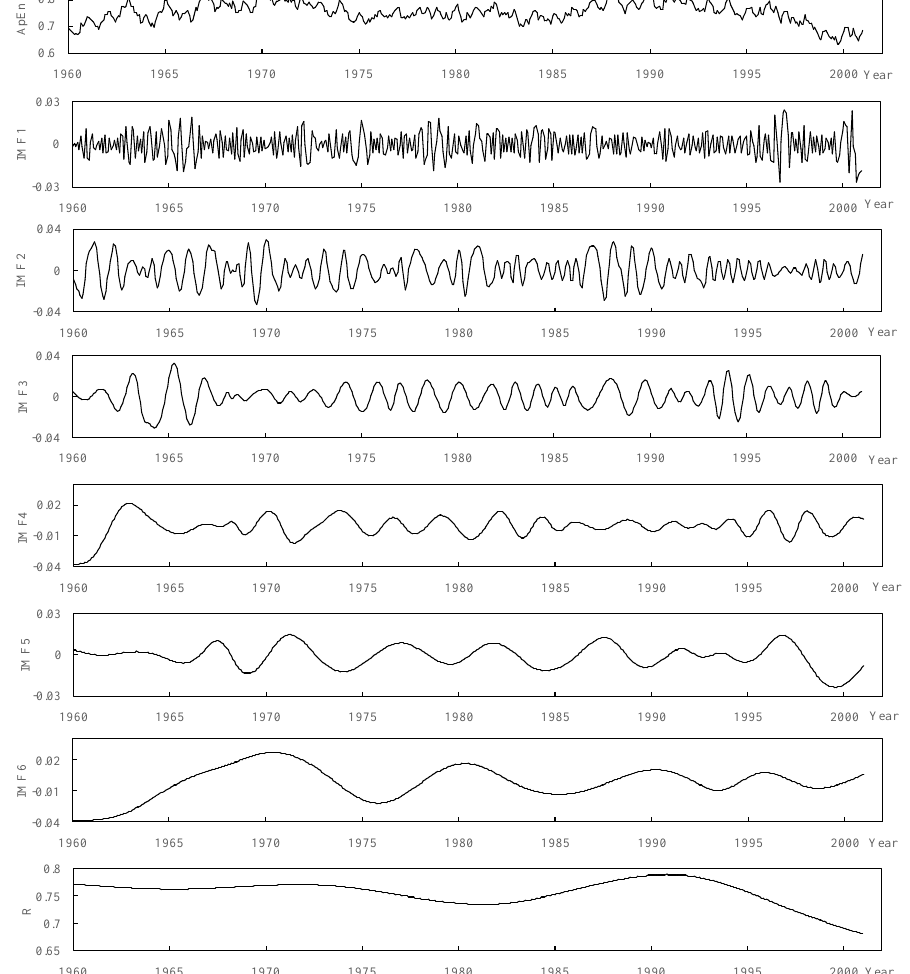
Figure 7. The Intrinsic Mode Function (IMF) components of precipitation ApEn by extreme-point Figure7. The Intrinsic Mode Function (IMF )components of precipitation ApEn by extreme-point symmetric mode decomposition (ESMD). symmetric mode decomposition